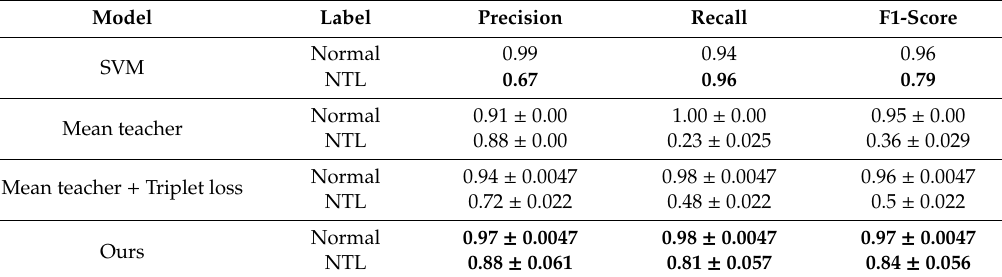
Table 5. Results by di ff erent model